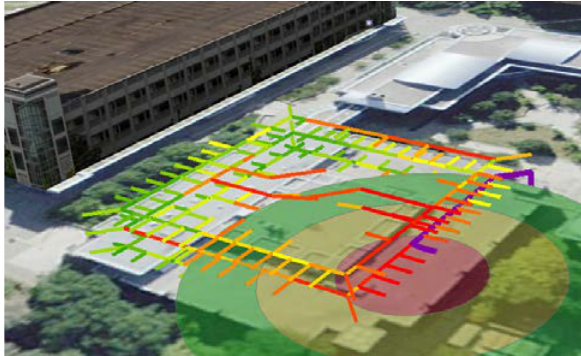
Figure 9. 3D Visualization of evacuation routes using Google Earth